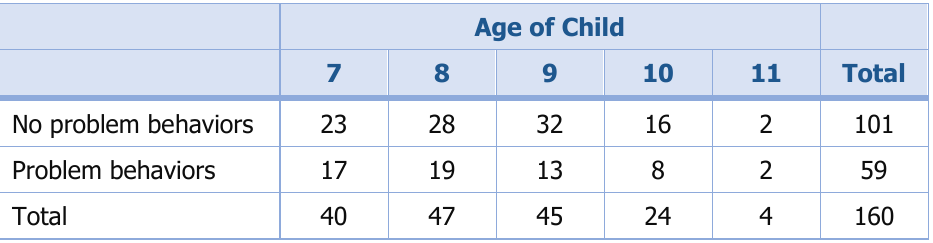
Table 2. Crosstabulations of Problem Behaviors by